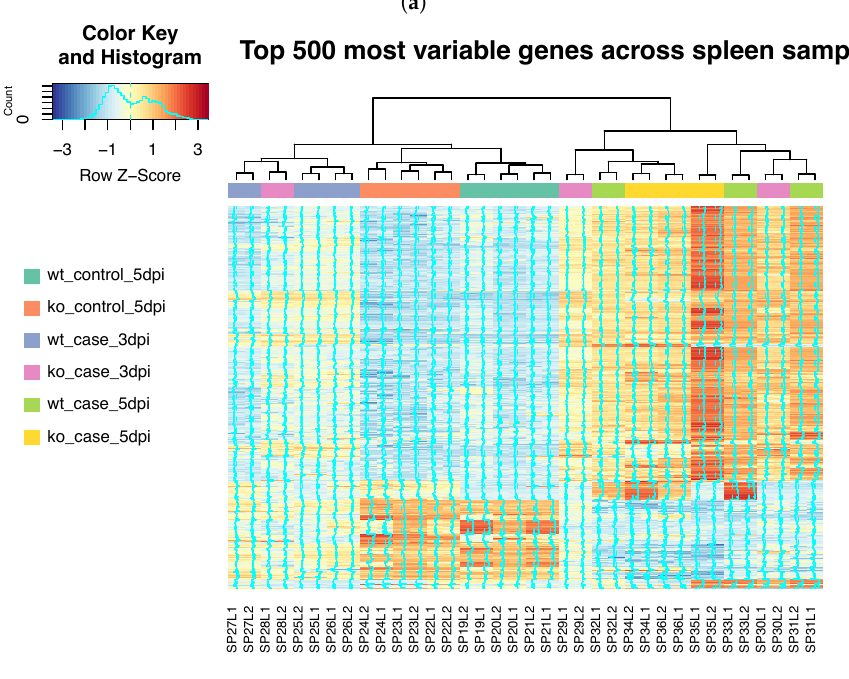
Figure A2. Top 500 most variable genes in ( a ) liver and ( b ) spleen samples. Log2-normalization was applied over the Counts per Million (CPMs) in order to properly compare distributions. Variance estimation reaffirms the homogenity of control vs. case samples. Overall, differences are also observed between 3 and 5 d p.i. case